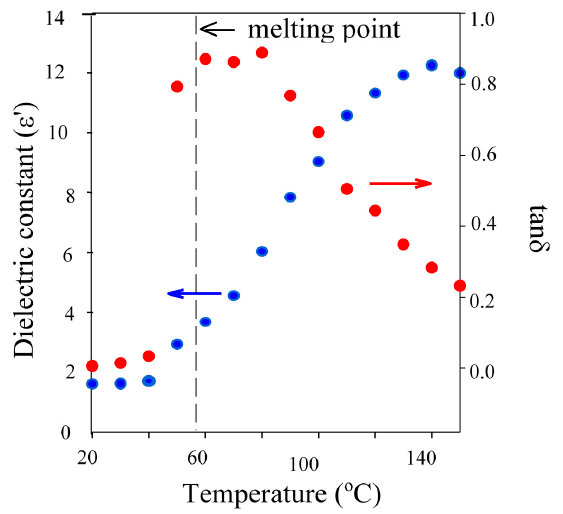
Figure 3. Plot of dielectric constant ( ) and tan δ ( ) against temperature for TMP demonstrating the influence of the melting transition on dielectric properties.